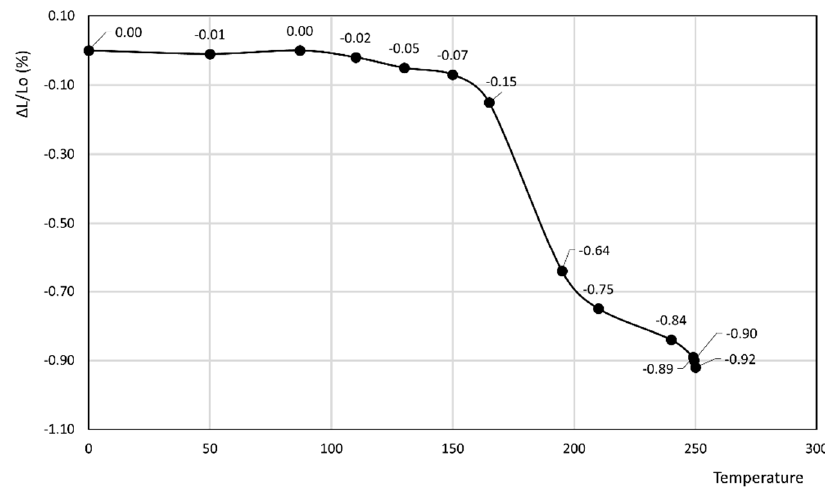
Figure 4. Thermodilatometric curve of rock 4, Neapolitan Yellow Tuff from Chiaiano.